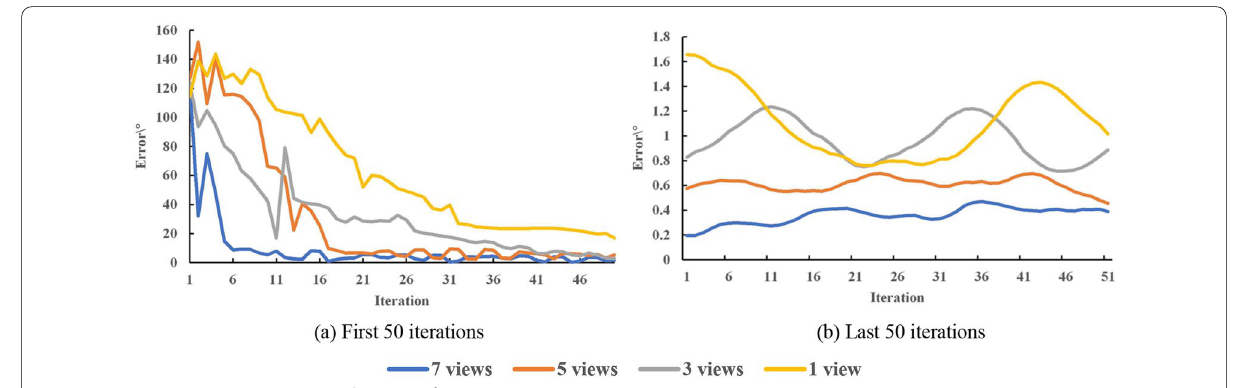
Figure 8 Training process to estimate the pose of view 8